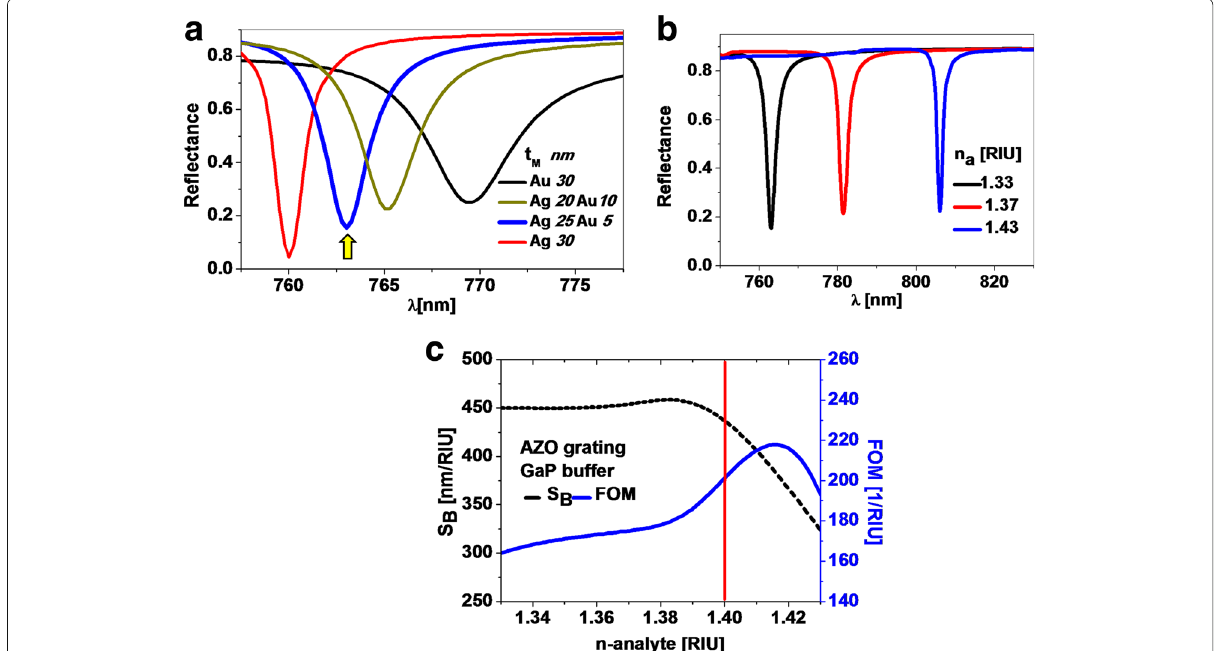
Fig. 4 a Spectral reflectance for single-metal 30-nm-thick layer made of gold (black) or silver (red), and for bi-metallic layer for two thicknesses combinations (blue and green). The yellow arrow selects the response for the optimum arrangement (25 nm-Ag / 5 nm-Au). b Spectral reflectivities of the optimum device that use a GaP buffer layer. The peaks show a similar sharpness for three different values of the index of refraction. c Sensitivity (left axis and black dashed line) and FOM (right axis and blue solid line) of the optimized sensor for an extended range of refractive index. The vertical line denotes the limit analyzed in the previous design where the buffer layer was made of AZO and the metallic layer was made of